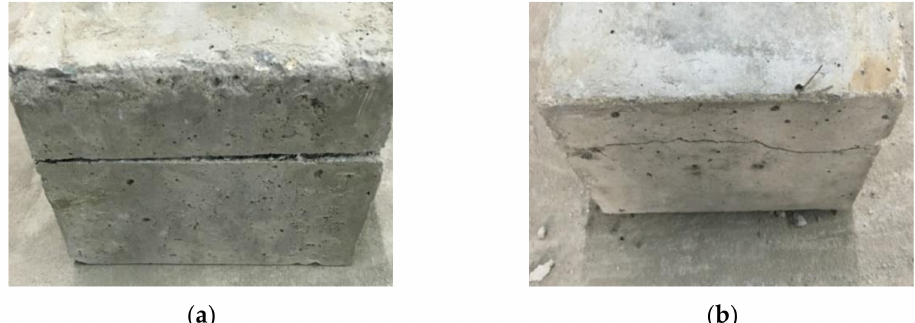
Figure 4. Shear failure mode of the recycled aggregate concrete for: ( a ) surface of the concrete specimen along the vertical shear direction; and ( b ) surface of the concrete specimen along the horizontal shear direction.